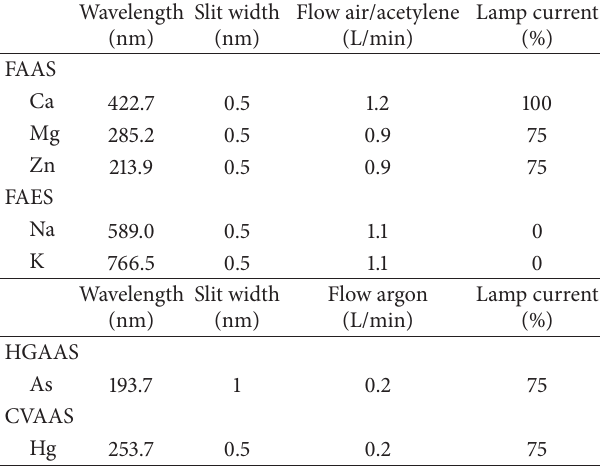
Table 1: Instrumental analytical conditions for atomic absorption spectrometry (flame and hydride generation technique) and for atomic emission spectrometry (flame technique) of investigated